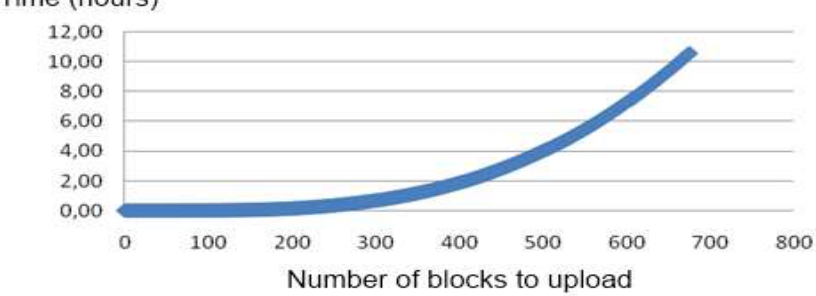
Figure 9. Time required to upload a new matrix of data, depending on its size, using SQL commands.